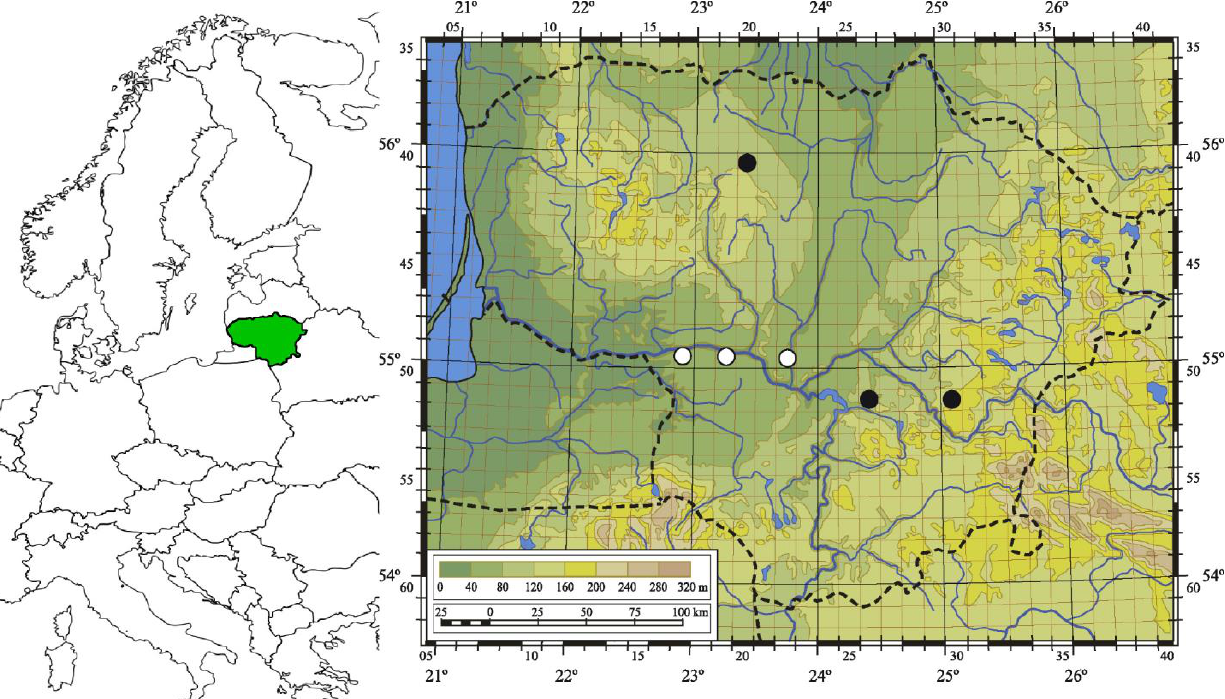
Figure 1. Position of Lithuania in Europe ( left ) and location of the Cornus sanguinea subsp. sanguinea (empty circles) and Cornus sanguinea subsp. australis (black dots) sampling sites for reproductive traits in Lithuania ( right ). Table 1. Locations of Cornus sanguinea subsp. sanguinea and Cornus sanguinea subsp. australis sampling for the study of reproductive traits in